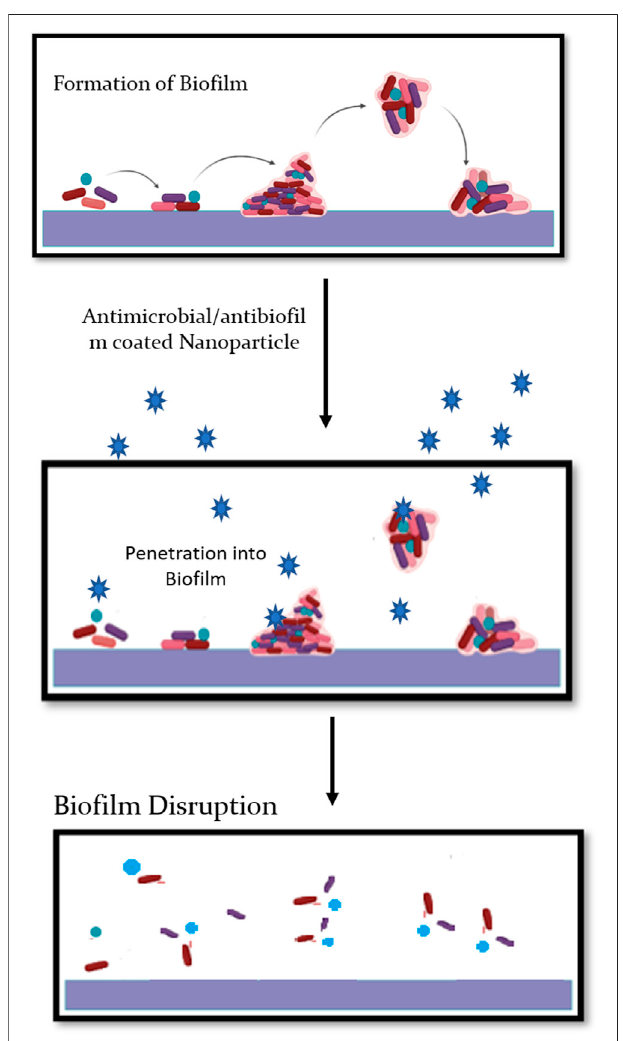
FIGURE 2 | The nanoparticles act on pre-formed bio fi lms and causes disrupting of bio fi